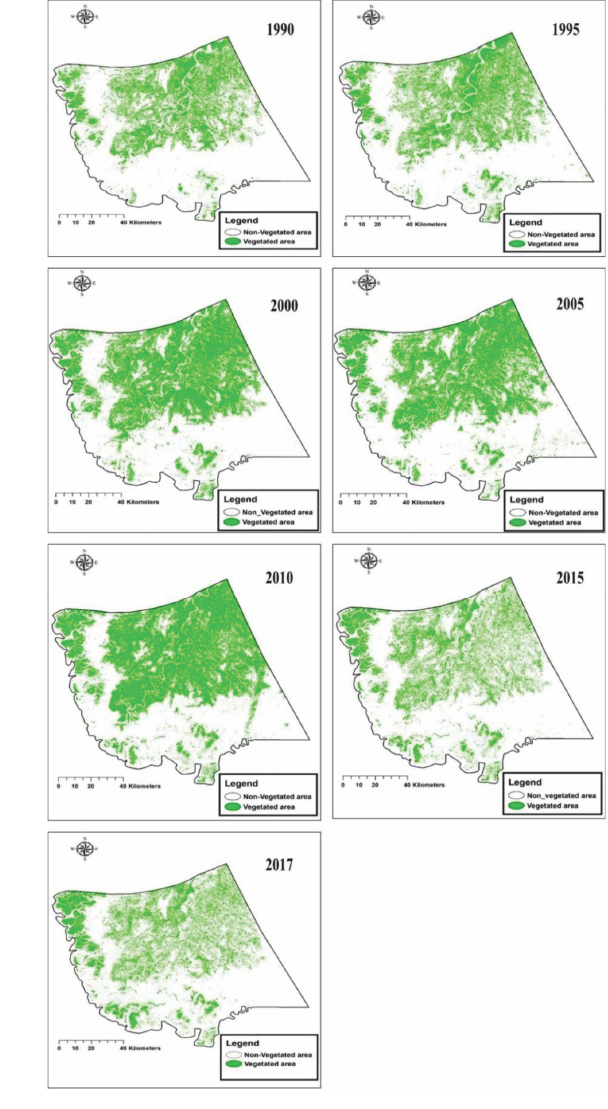
FIG. 2. VEGETATION MASKS OF THE INDUS DELTA FOR DIFFERENT YEARS